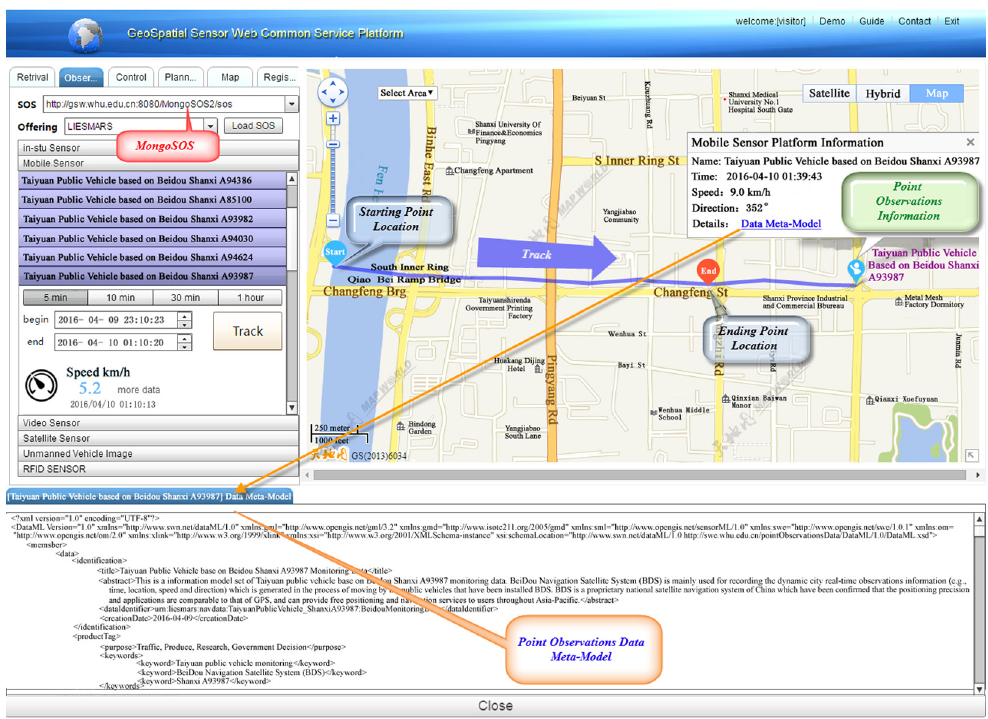
Figure 11. Desktop web visualization of the public vehicle monitoring based on BeiDou Navigation Satellite System. Table 5. Mappings from the DMM to other geospatial and observation-related description models.